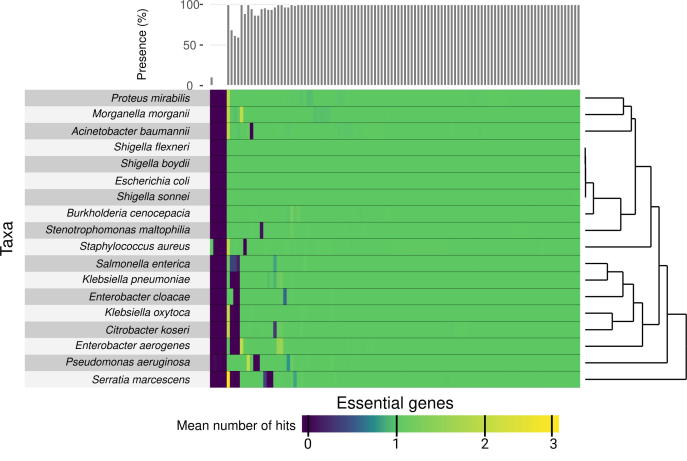
Frequency of essential genes per species Shown is the mean number of HMM hits coded in color gradient from blue to yellow. Rows (species) and columns (essential genes) were ordered using hierarchical clustering (Euclidean distance and average linkage). The bar plot at the top of the heatmap shows the frequency of the essential genes over all isolates. HMM, hidden Markov model.